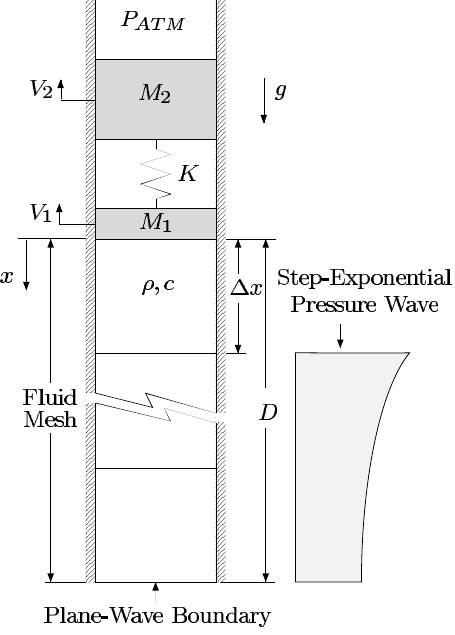
Fig. 1. CAFE-model schematic for a 2-mass oscillator floating on a fluid